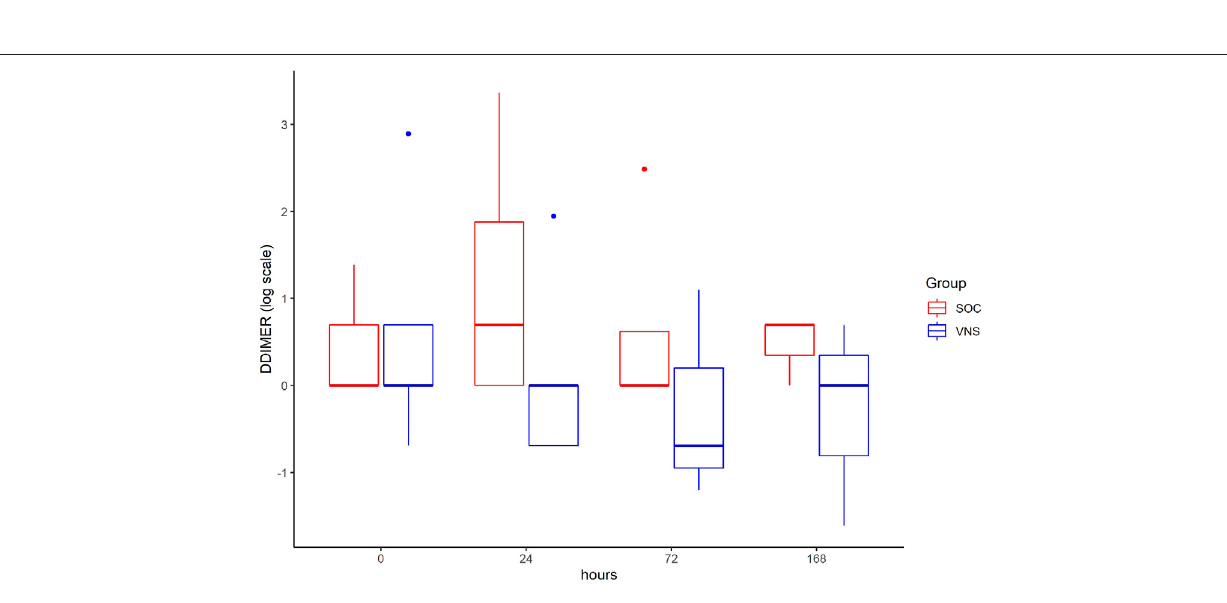
Frontiers in Physiology |